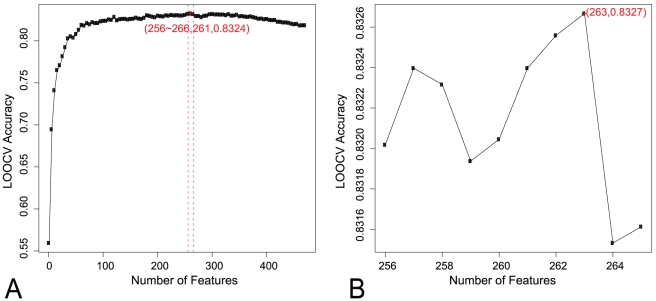
The curve of IFS.(A) The IFS curve with a step width of 5. The highest accuracy was achieved with 261 features, which suggest the optimal feature set should have more than 256 and less than 266 features; (B) The IFS curve between index 256 and 265. Refine the accuracy around S261, by calculating accuracies using feature sets S256, S257… S265. The highest accuracy of IFS was 83.27% using 263 features. These 263 features formed the optimal feature set.